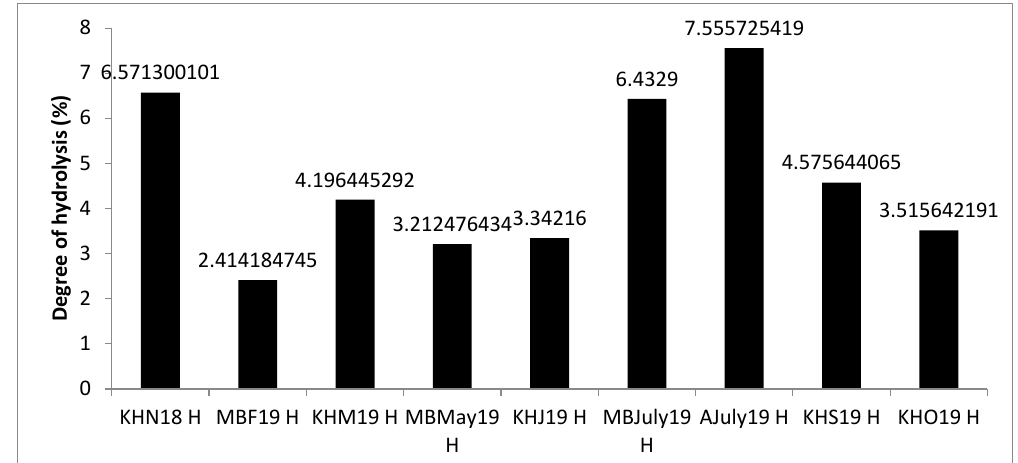
Figure 1. The Degree of hydrolysis (DH) of mussel by-product Protamex ® hydrolysates (H) determined using the Adler-Nissen pH stat method. The 9 samples from the three sampling sites Mulroy bay (MB), Killary harbour (KH) and Ardgroom (A), collected from November 2018 to October 2019, were used for hydrolysis. Analysis was performed in triplicate (n = 3). Bars sharing the same letter are not significantly di ff erent according to Tukey’s honestly significant di ff erence (HSD) test.